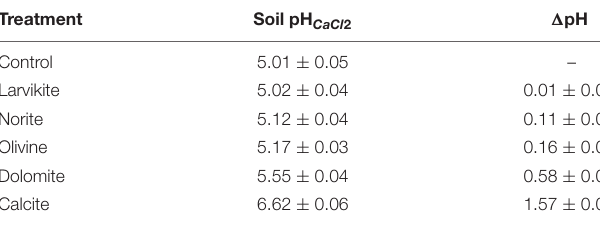
TABLE 1 | Soil pH as affected by the mineral